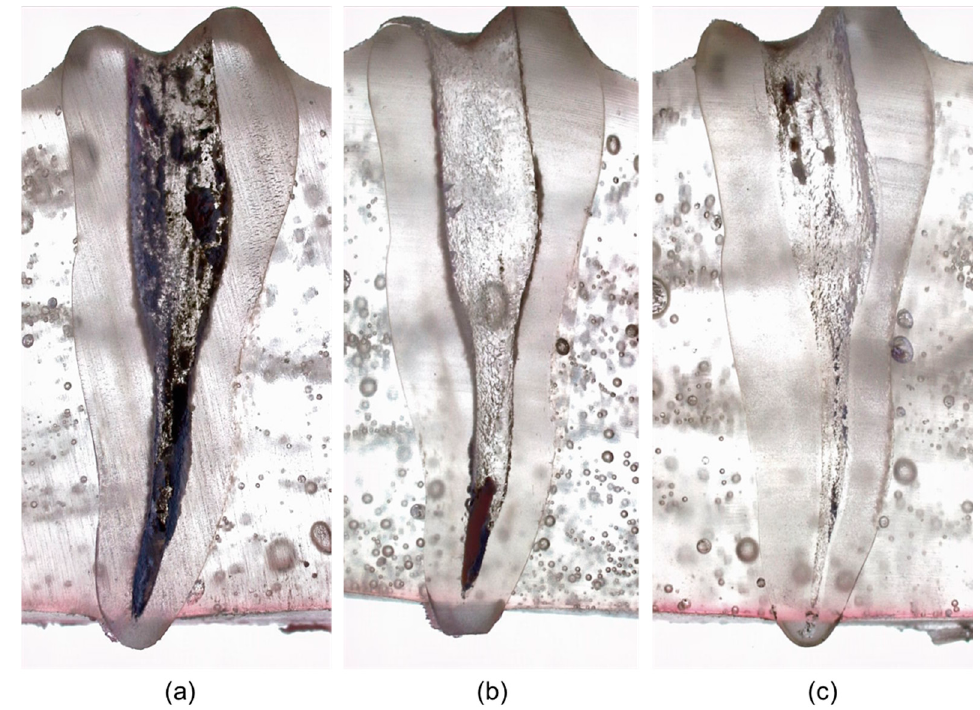
Figure 3. Stereomicroscope images of remaining intracanal filling materials in three groups: ( a ) conventional group; ( b ) passive ultrasonic irrigation group; ( c ) Gentlefile Brush group.